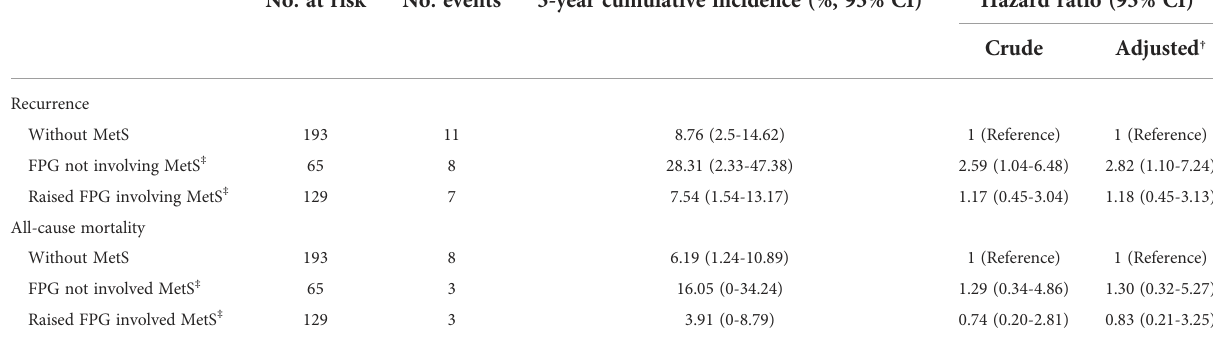
TABLE 4 Associations of subtypes of metabolic syndrome with prognosis.